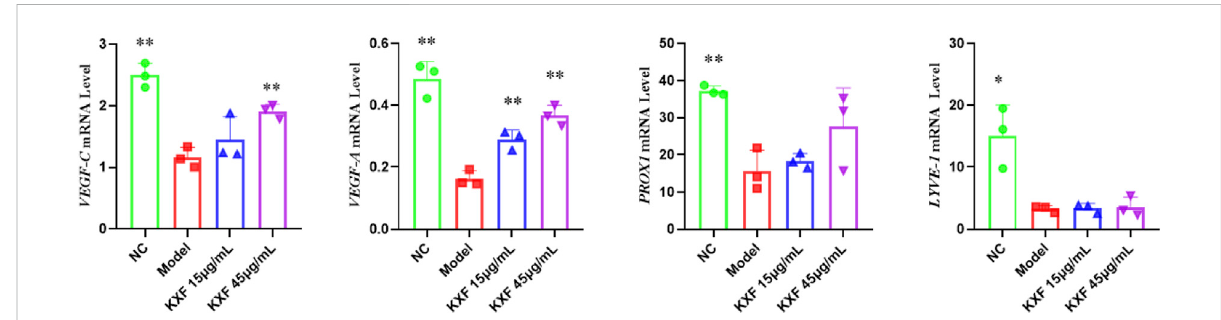
FIGURE 9 KXF increased the expression of mRNAs associated with lymphatic vessels after zebra fi sh thoracic lymphatic vessels were damaged by the VEGFR-3 kinase inhibitor (MAZ51). After the pre-treatment of MAZ51 (6 h), the expression levels of VEGF-C , VEGF-A , PROX1 , and LYVE-1 mRNA in impaired zebra fi sh with two dosages of KXF for 48 h. * p < 0.05 vs. Model group, ** p < 0.01 vs. Model group.